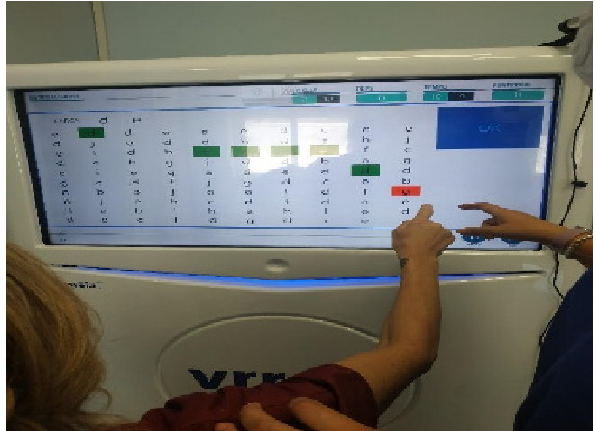
Figure 1. shows the 2D VR training modality: Psychiatric therapist guided the patient in carrying out goal-oriented, manual-eye coordination exercises, while she is seated in a wheelchair in front of the VRRS station. In red, it is marked the wrong response.